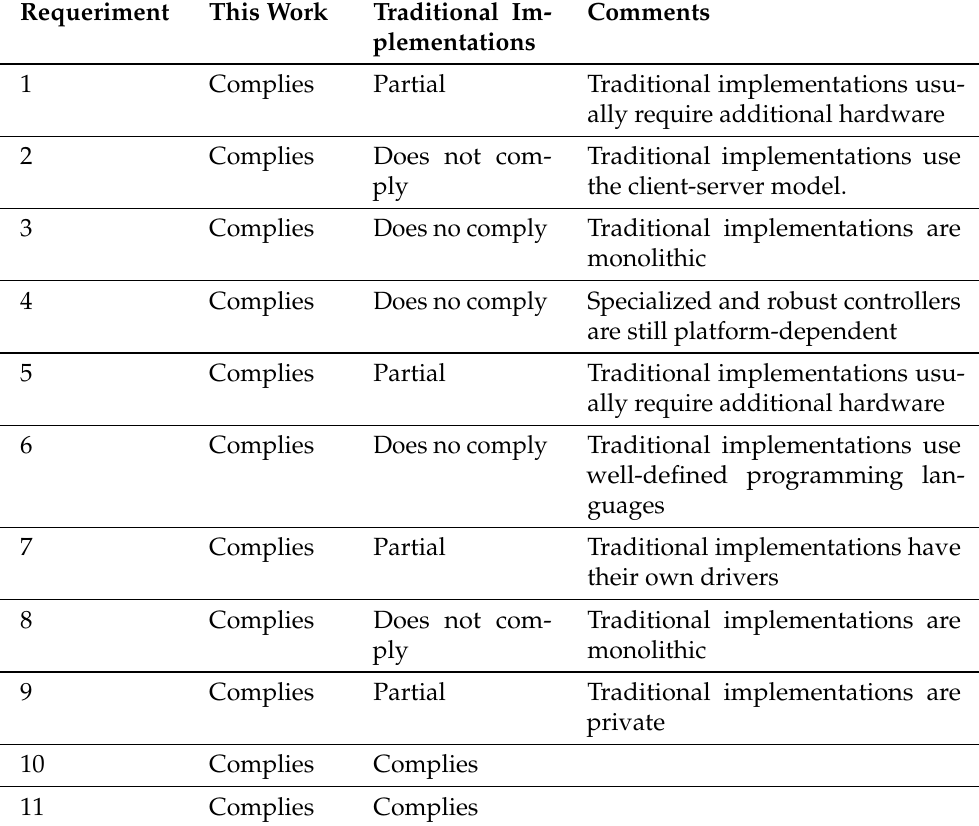
Table 6. Comparison with traditional implementations based on the requirements of